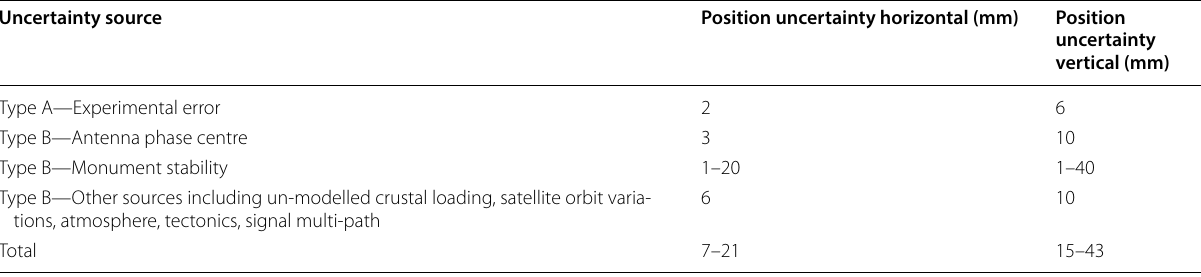
Table 1 Uncertainty sources (95% confidence level) for position, determined from GPS, and the total uncertainty, assuming the normal distribution of the uncertainty sources, high degrees of freedom and a coverage factor, k , of